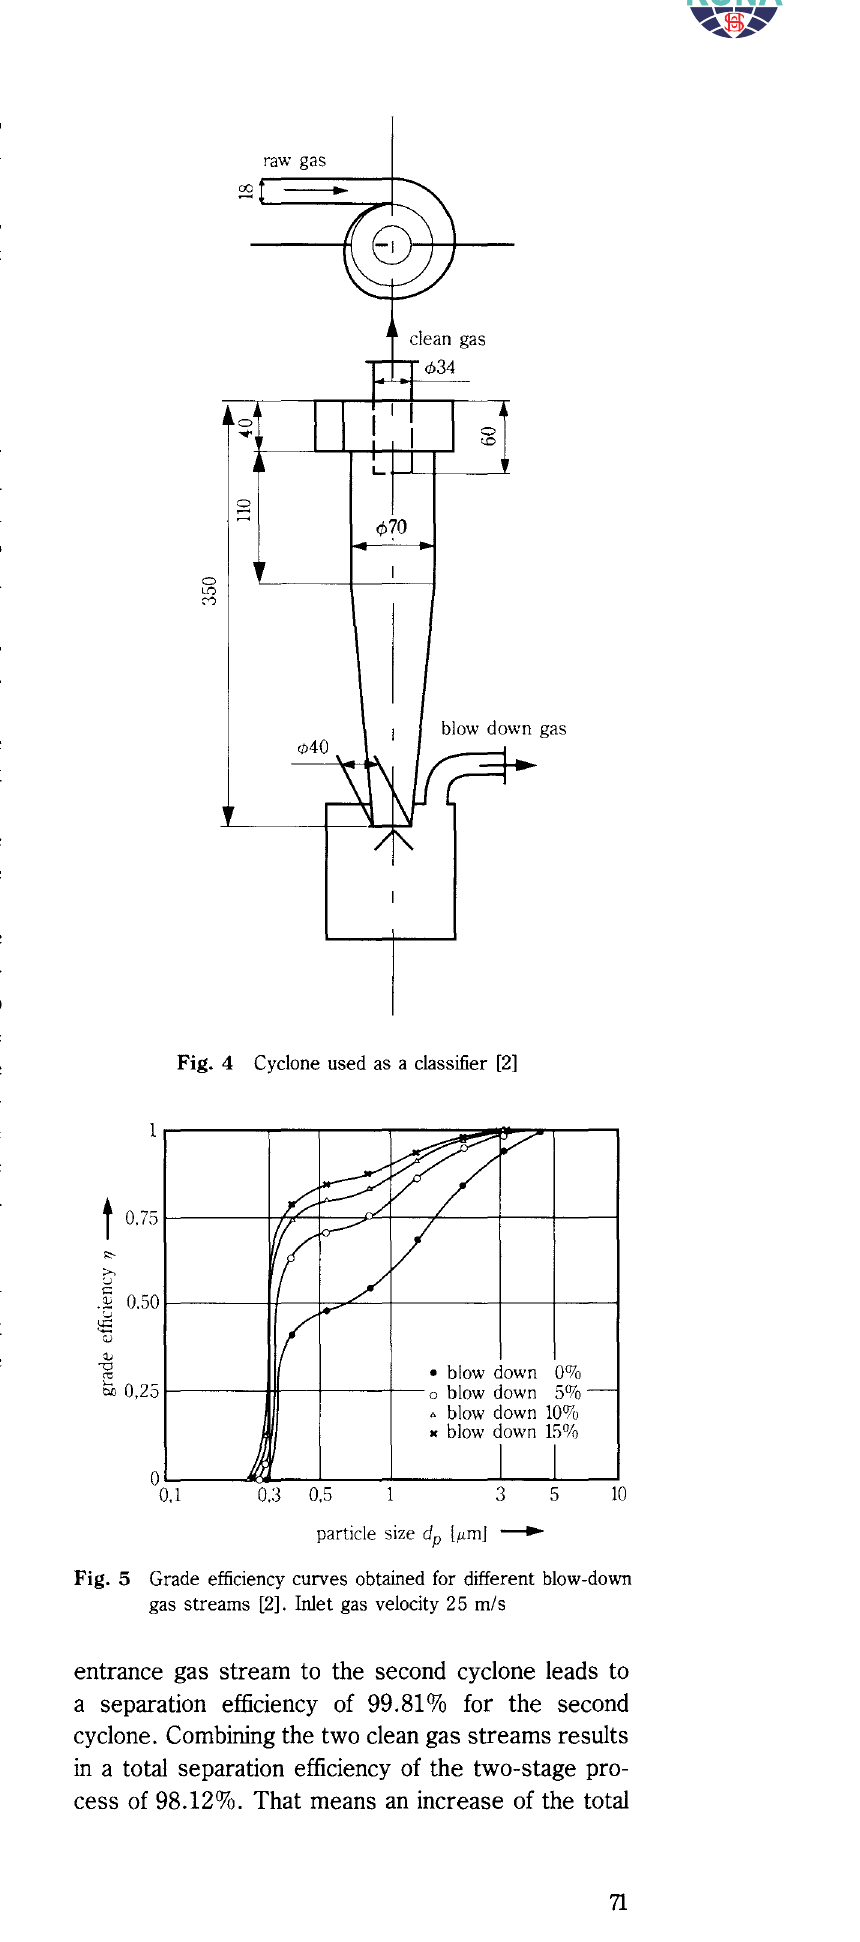
Fig. 3 Experimental set-up used by K. Iinoya et a!. [2]